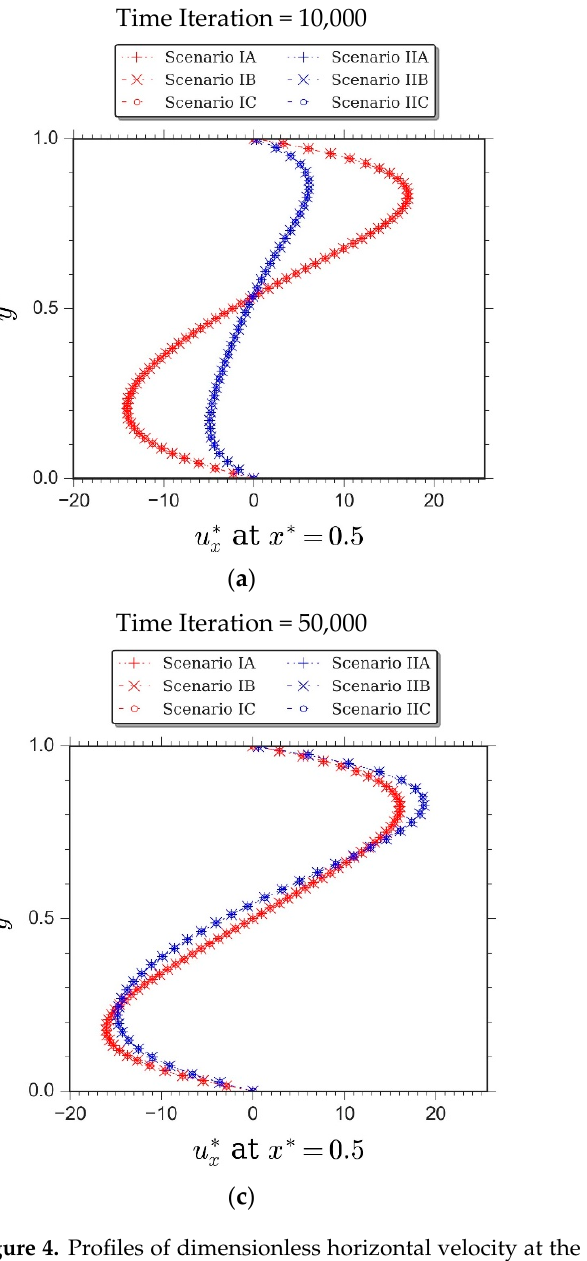
Figure 5. Computational overhead of disparate LBM schemes in modelling natural convection in a differentially-heated cavity with Ra = 10 4 , Pr = 0.71 , τ υ = 0.6 and Ma = 0.1 , starting from the unsteady period up to the accomplishment of the steady-state period. 5.2. Simulation of Rayleigh-Bènard Convection After undertaking evaluation regarding computational characteristics of distinct LBM scenarios upon simulating natural convection in a differentially-heated enclosure in the previous section, the current segment of the article aims at elucidating the capacity of disparate LBM scenarios while simulating the Rayleigh-Bènard convection (RBC) phenomena as illustrated in Figure 6.